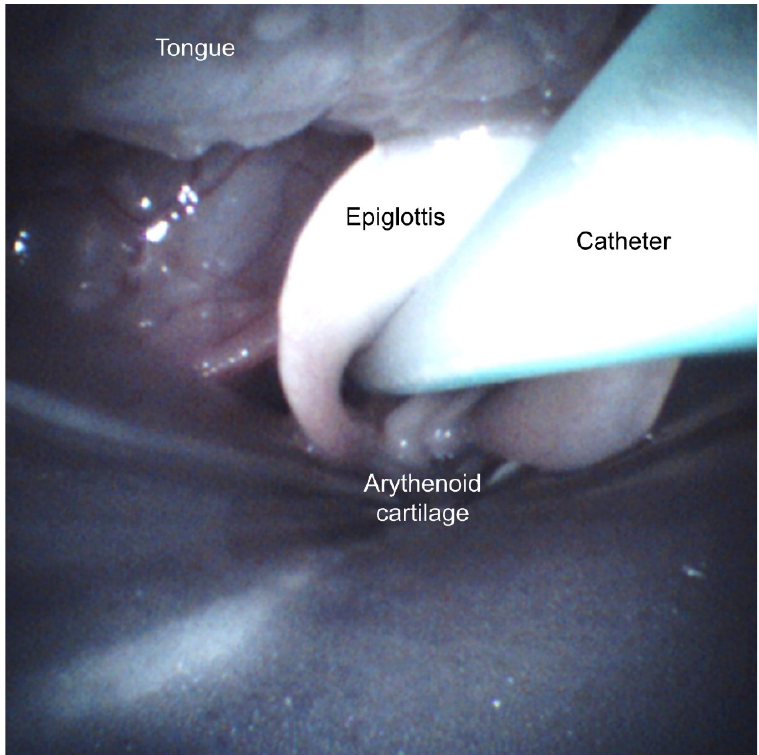
Figure 4. Picture of the correct position of the laryngeal mask airway. The picture was obtained from the video recording during insertion.